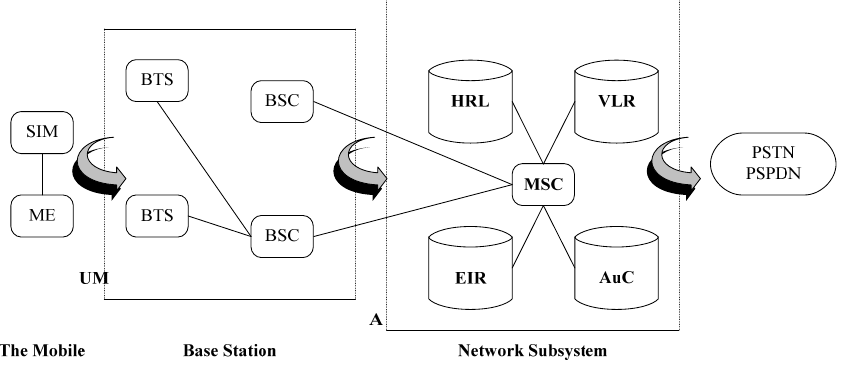
Figure 1. The architecture of the GSM network.